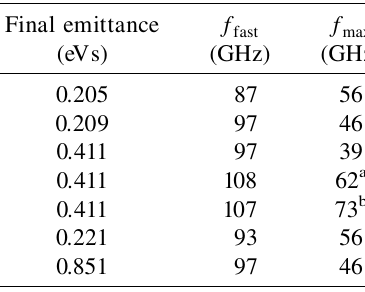
Emittance growth for several FMI cases. Initial emittance Bunch population Final